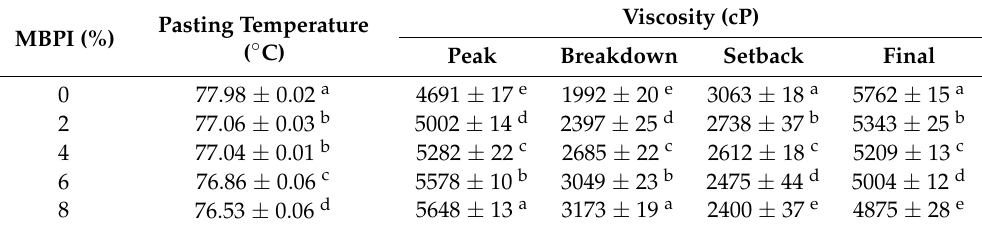
Table 1. Pasting properties of NCS/MBPI gels at different MBPI